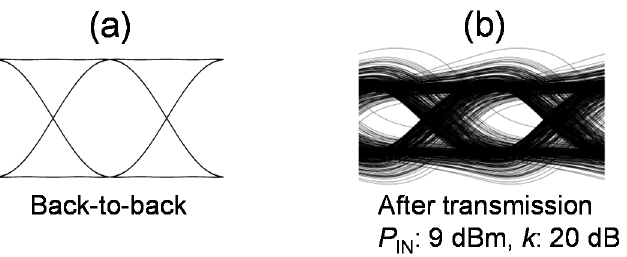
Figure 14. Back-to-back and transmitted signal eye diagrams, ( a ) back-to-back, ( b ) after 100-km transmission.